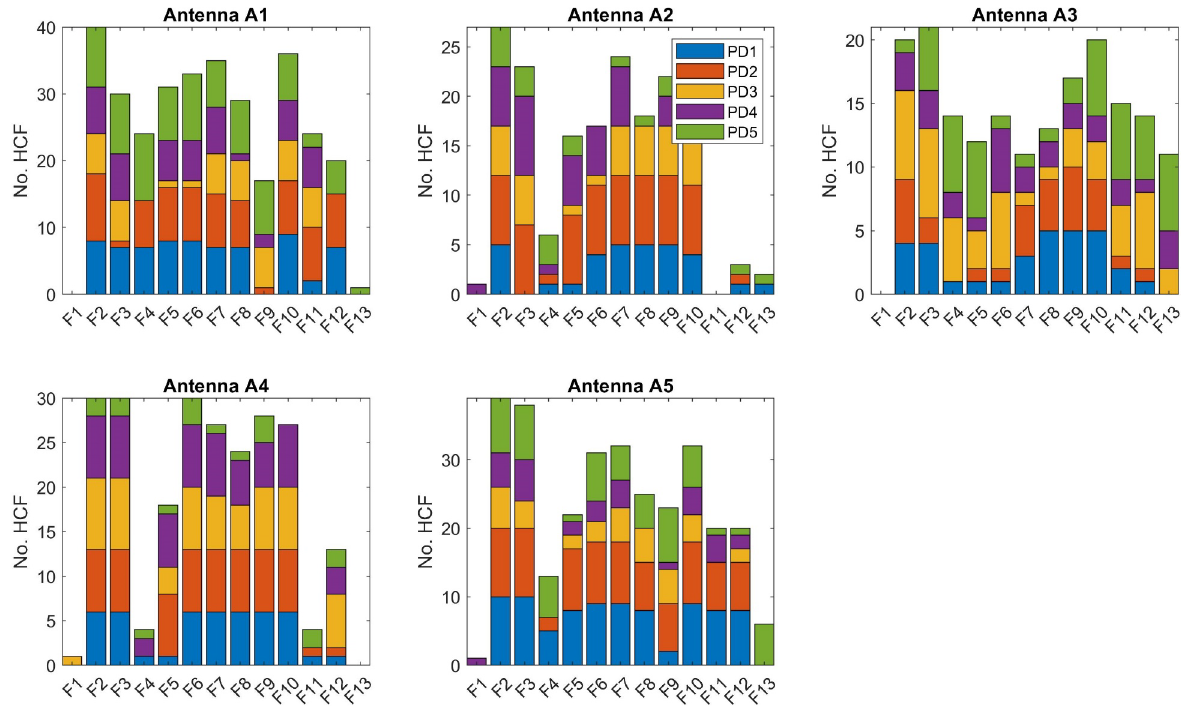
Figure 8. The number of times a given feature was highly correlated (no HCF) with another: | r | > 0.7.